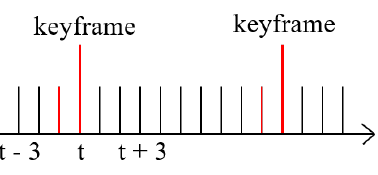
Figure 8. The relationship between keyframes and intermediate frames. The red line represents the point cloud frames used in this